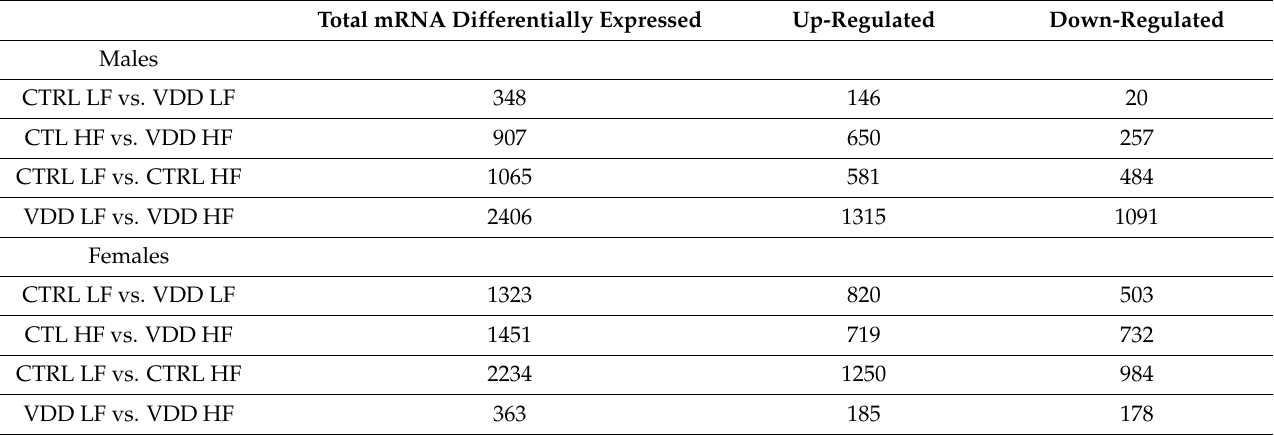
Table 1. The total number of differentially expressed mRNA genes, including up-regulated and down- regulated genes, in both males and females, was determined using data filtering with padj < 0.01 and FC > 1.5 or < −